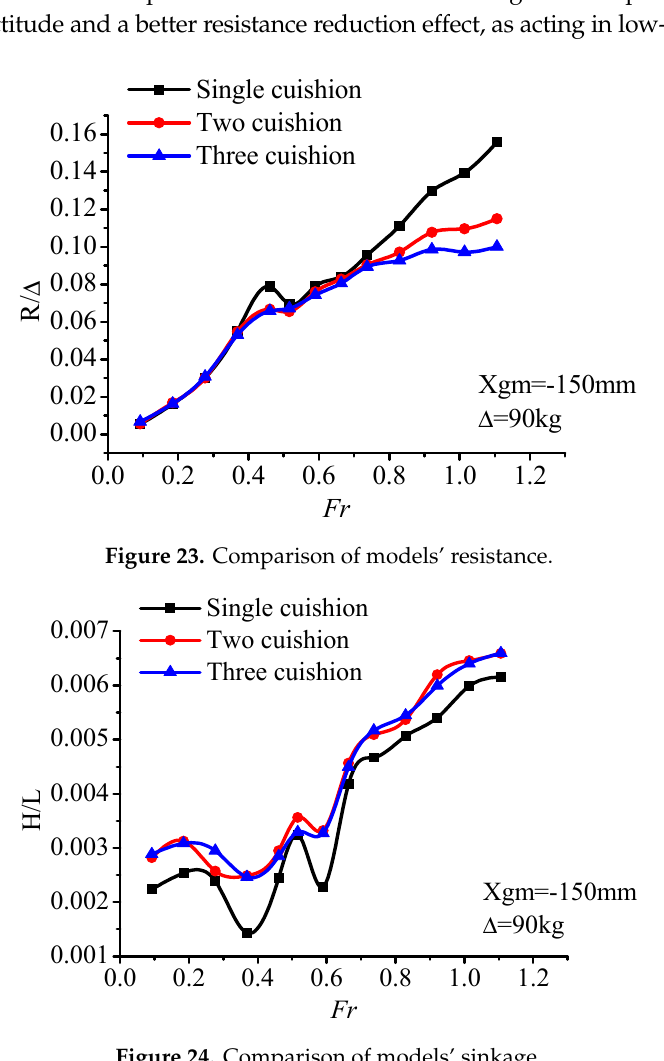
Figure 24. Comparison of models’